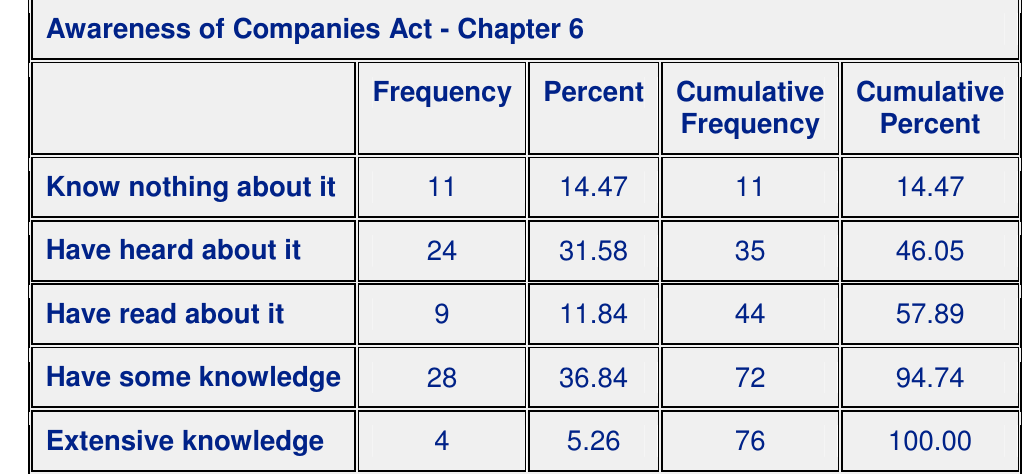
Table 3: Respondents’ awareness of the